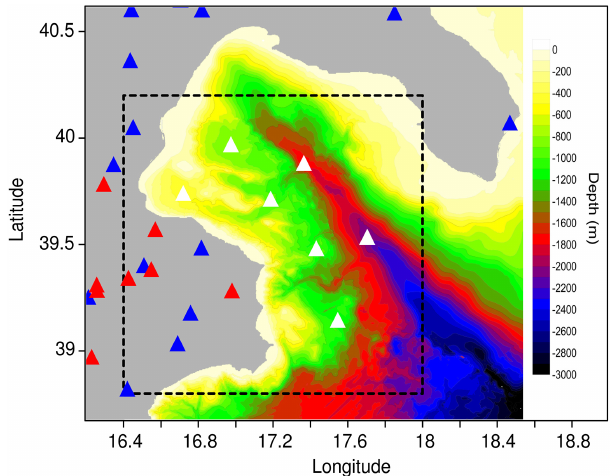
Figure 3. Bathymetric map of the Taranto Gulf; the dashed square indicates the area of main interest; blue triangles are INSN stations, red triangles are CUSN stations, white triangles are candidate sites for OBS / H